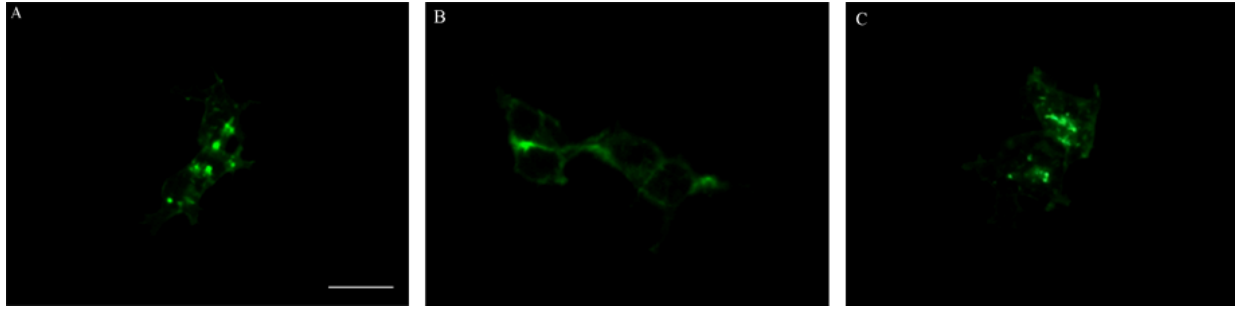
Figure 4. Effect of YNS-PY-F on SDF-1  induced CXCR4 internalization. ( A ) Negative control: EGFP-CXCR4 mainly distributed in the cytoplasm of 293 T cells treated